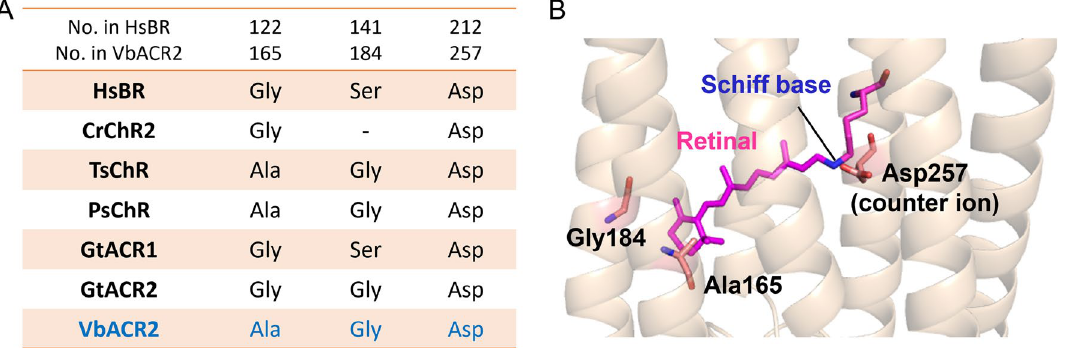
Figure 5. Hypothetical mechanism of the blue-shifted property of VbACR2. ( A ) Comparison of amino acid residues around the retinal. ( B ) AlphaFold structural model for VbACR2 (https:// alpha fold. ebi. ac. uk/). The putative key residues of VbACR2 for its color tuning (Ala165 and Gly184) are indicated on the model structure (orange sticks). The putative counterion (Asp257) is indicated (orange stick). The retinal and the Schiff base linkage with Lys residue of the crystal structure of GtACR1 are shown (magenta